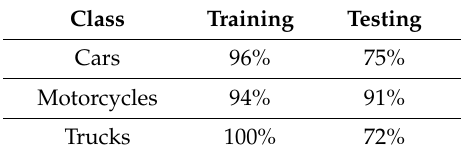
Table 2. Vehicles, in 3 classes, training and testing prediction accuracy.